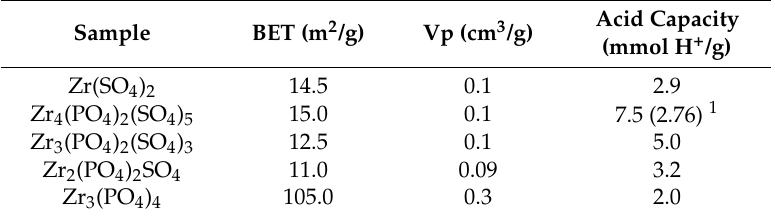
Table 1. Textural properties in terms of specific surface area (BET) and total pore volume and acid capacity by NaOH titration determined for the zirconium phosphate–sulphate